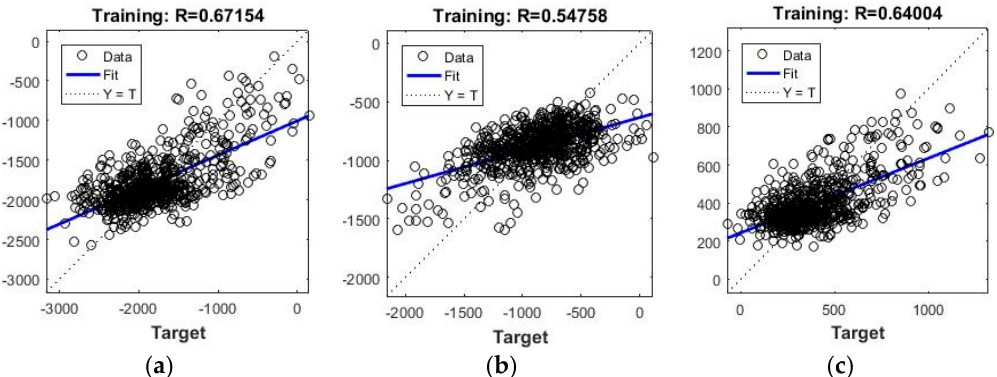
Figure 7. BNN two hidden layers fitting results based on the 85% of the samples: ( a ) Group of hyperspectral vegetation indices against GPR slice depth between 0.00–0.20 m; ( b ) Group of hyperspectral vegetation indices against GPR slice depth between 0.20–0.40 m; and ( c ) Group of hyperspectral vegetation indices against GPR slice depth between 0.40–0.60 m.